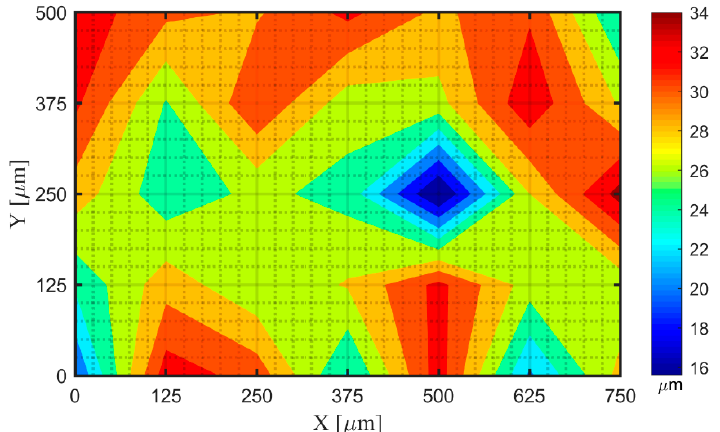
Electronics 2018 , 7 , x FOR PEER REVIEW Figure 21. Contour of the mean residual between certified and measured points of Simulation No. 10.